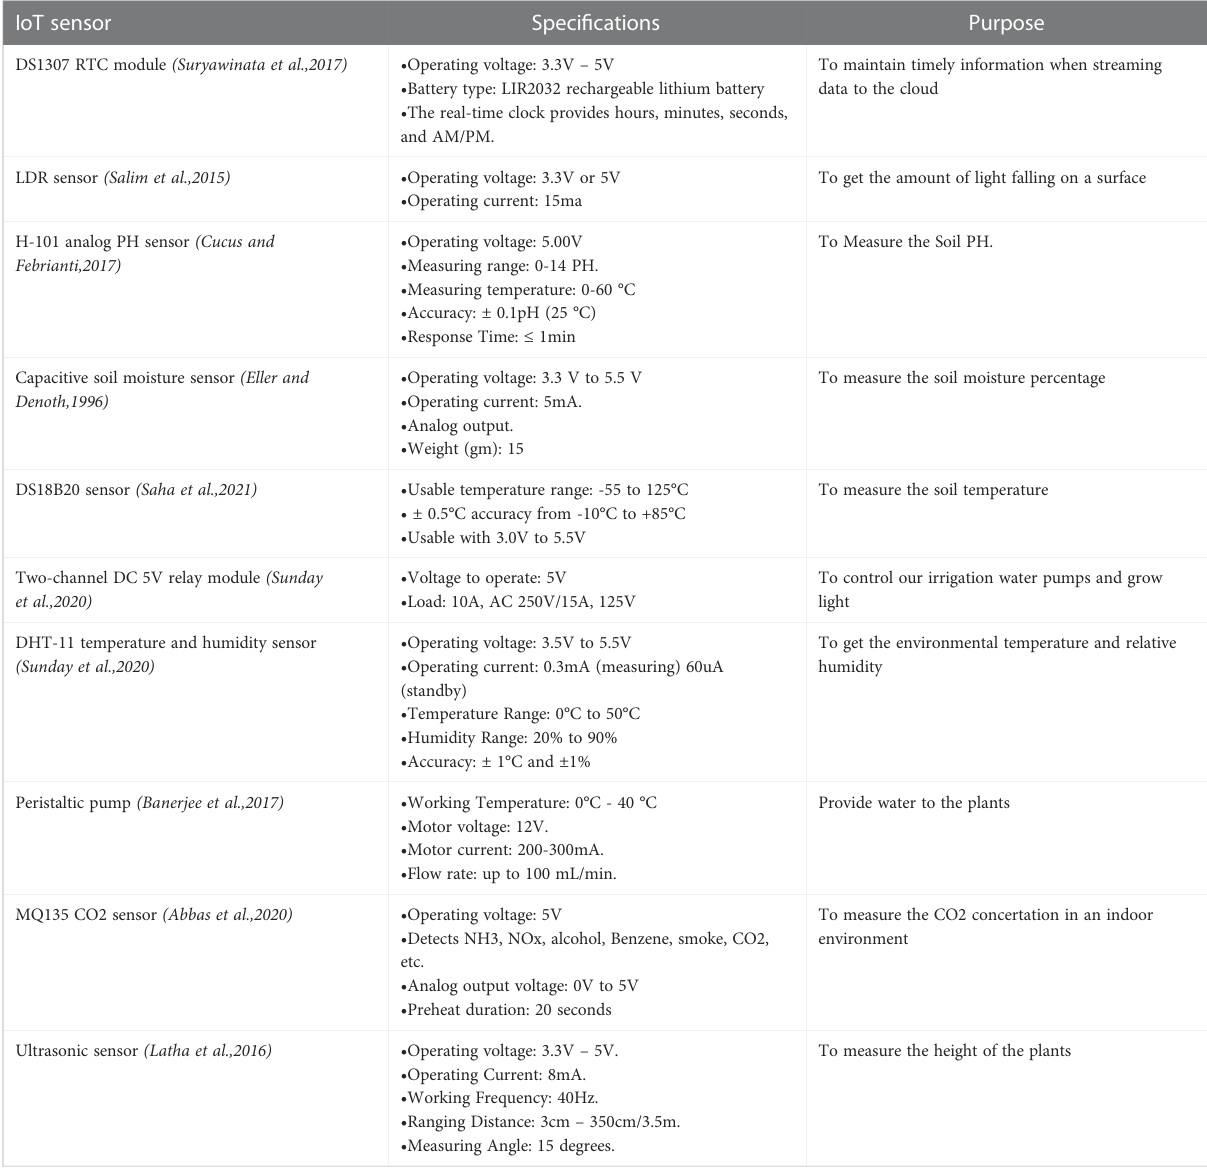
TABLE 1 Speci fi cations and the purpose of IoT devices. IoT